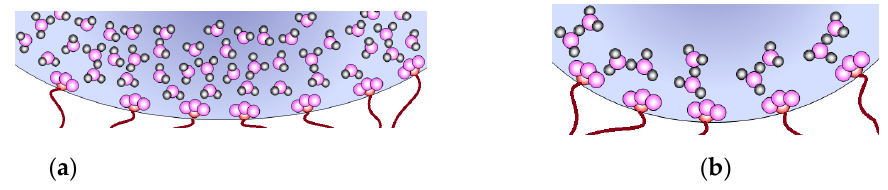
Figure 6. Scheme of proton transfer in membranes with high ( a ) and low ( b ) water uptake.